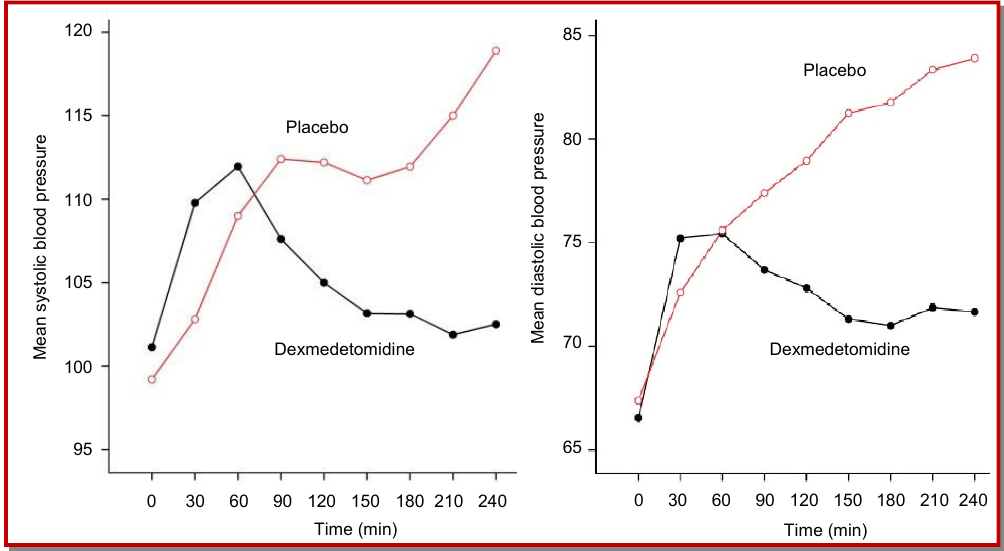
Figure 2: Mean systolic and diastolic blood pressure